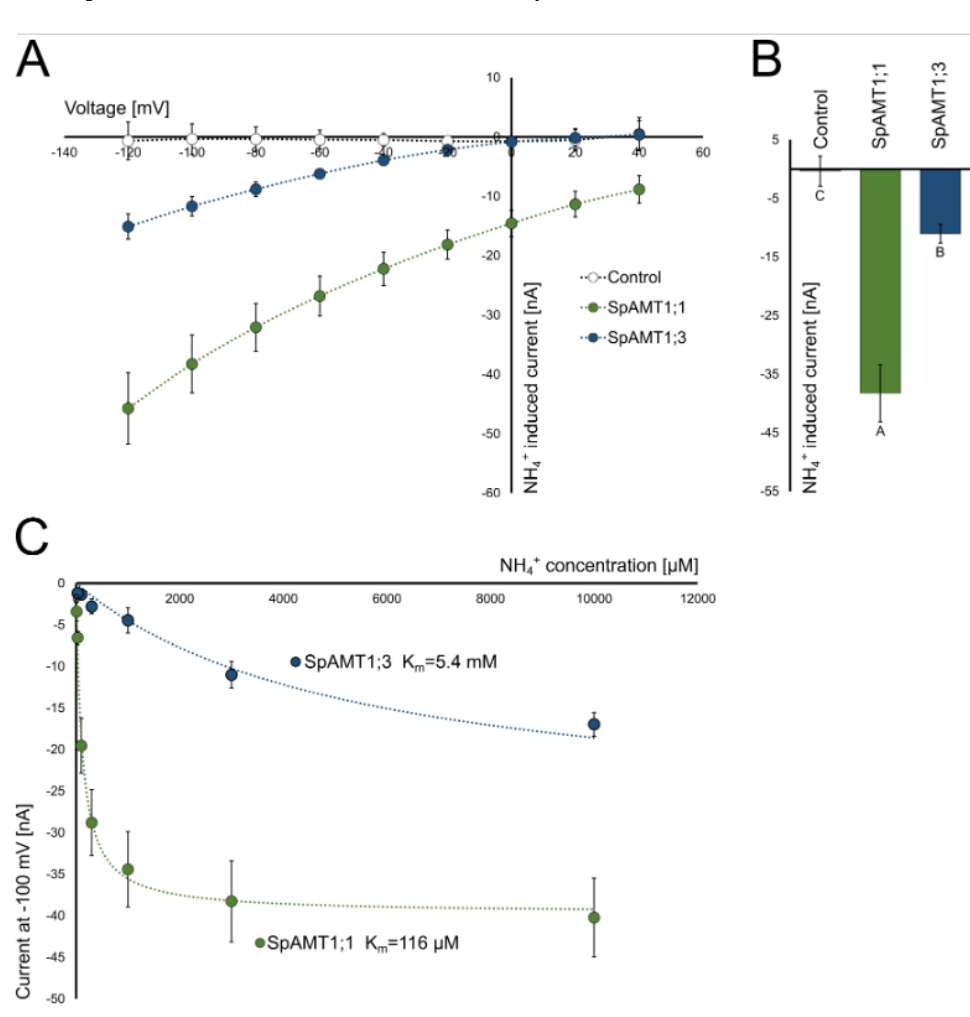
Figure 4. Functional characterization of SpAMT1;1 and SpAMT1;3 in Xenopus laevis oocytes: ( A ) Current/Voltage plot of ammonium induced currents in SpAMT1;1 and SpAMT1;3 expressing oocytes. Currents without ammonium were subtracted from currents with 3 mM ammonium; ( B ) For comparison of current intensities, ammonium induced (wash subtracted) currents by 3 mM and 100 mV are given as a bar chart; ( C ) Saturation kinetics of SpAMT1;1 and SpAMT1;3 mediated ammonium transport in oocytes using concentrations of ammonium from 0–10 mM NH (cid:2872) Cl . Data show means +/ − SEM; n ≥ 8.